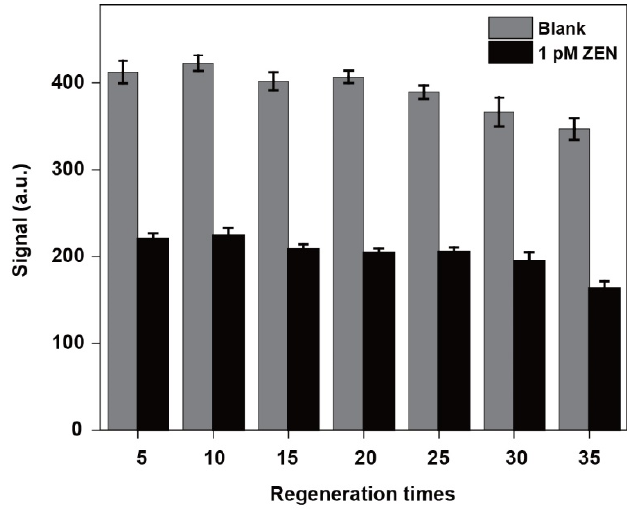
Figure 6. Regeneration tests of the NADL-EWOF aptasensor. The fluorescence intensities were the averaged values of every 5 cycles and background subtracted.